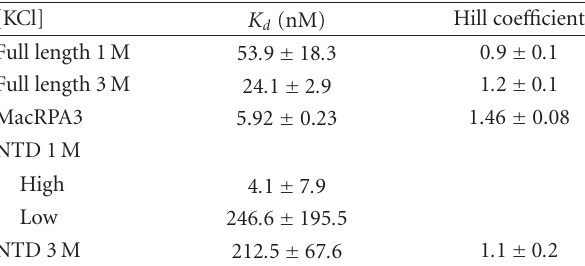
Table 1: Dissociation constants and Hill coe ffi cients calculated from a Hill binding model for HvRPA3 constructs compared with dimeric MacRPA3 [10]. A two-site binding model was employed for the NTD analysis in 1 M KCl as described in Section 2 . Protein concentration is for the monomer equivalent, with the exception of NTD in 1M KCl, where dimeric concentration was employed in model